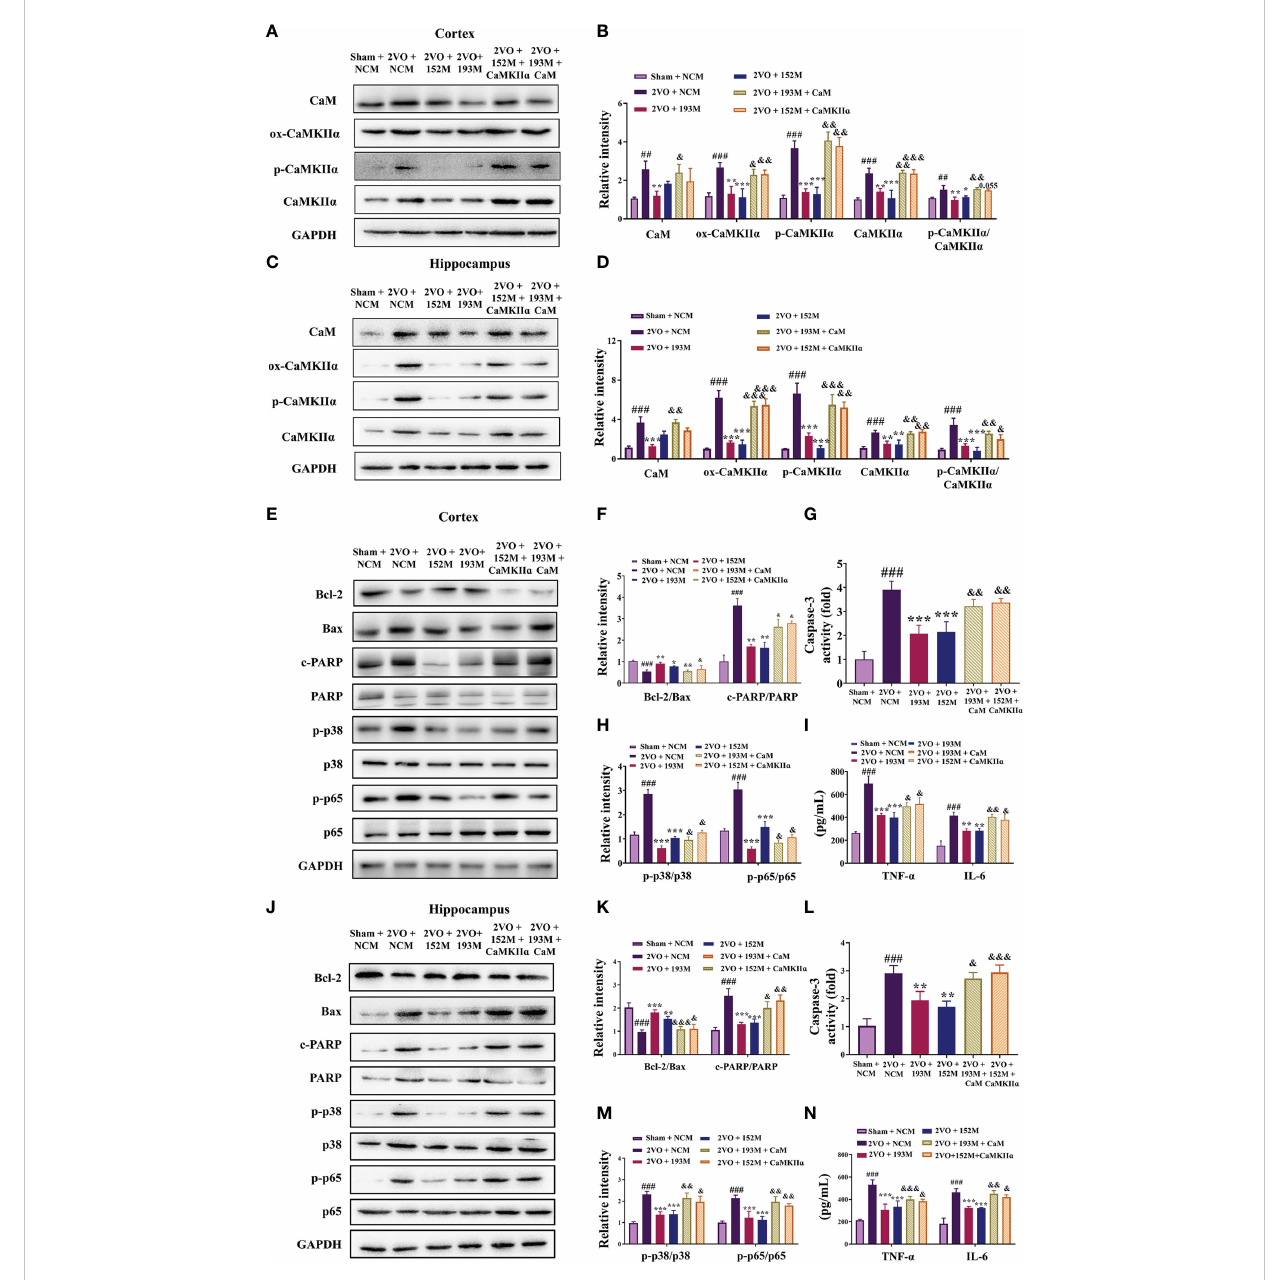
FIGURE 7 miR-193b-3p and miR-152-3p inhibited apoptosis and in fl ammation by targeting CaM/CaMKII a in vivo . (A, C) Representative Western blot bands for CaM, ox-CaMKII a , p-CaMKII a , and CaMKII a in the cortex (A) and hippocampus (C) . (B, D) Quantitative analysis of CaM, ox-CaMKII a , p-CaMKII a , CaMKII a , and p-CaMKII a /CaMKII a in the cortex (B) and hippocampus (D) . (E, J) Representative Western blot bands for Bcl-2, Bax, c-PARP, total PARP, p-p38, p38, p-p65, and p65 in the cortex (E) and hippocampus (J) . (F, K) Quantitative analysis of Bcl-2/Bax and c-PARP/PARP in the cortex (F) and hippocampus (K) . (G, L) Caspase-3 activity in the cortex (G) and hippocampus (L) assessed by ELISA. (H, M) Quantitative analysis of p-p38/p38 and p-p65/p65 in the cortex (H) and hippocampus (M) . (I, N) Levels of TNF- a and IL-6 in the cortex (I) and hippocampus (N) assessed by ELISA. Results represent the mean ± SD, n =3, ## P <0.01, ### P <0.001 vs. sham+NC, * P <0.05, ** P <0.01, *** P <0.001 vs. 2VO+NC, & P <0.05, && P <0.01, &&& P <0.001 vs.